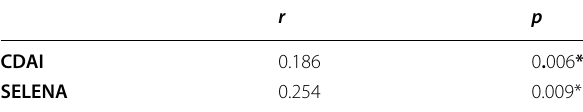
Table 5 Correlation between anxiety "Hamilton Anxiety Rating Scale" and disease activity measurements